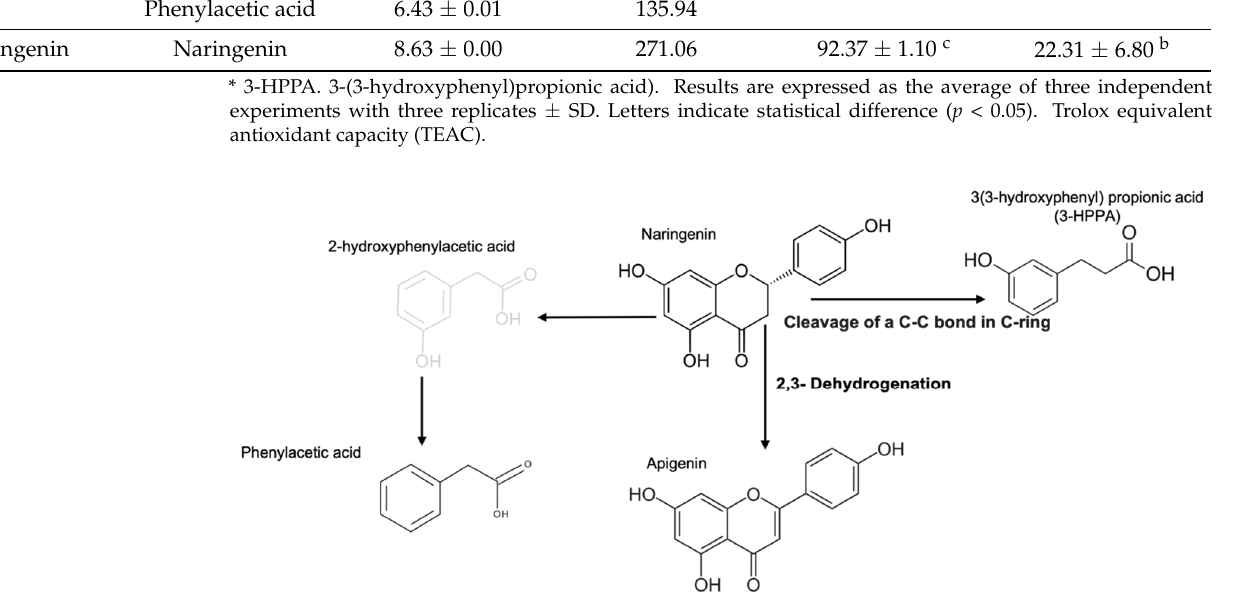
Figure 1. Proposed metabolic pathway of naringenin by colonic microbiota. Detected metabolites are in black, non-detected metabolites are in grey.